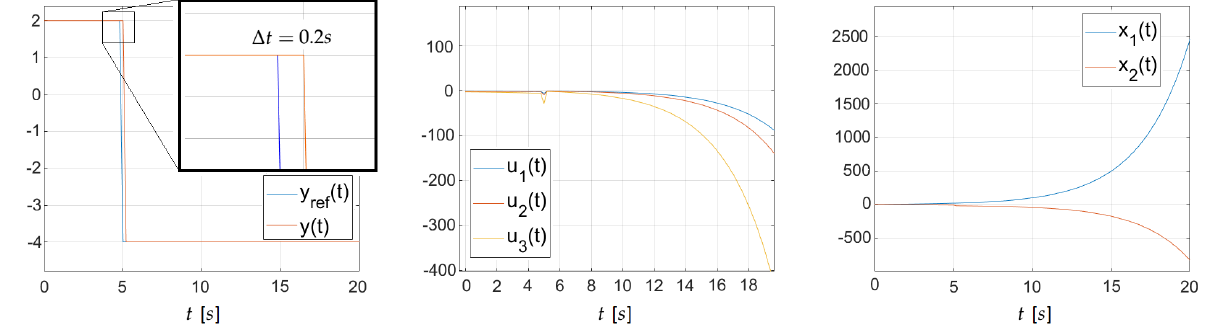
Figure 2. Perfect control plots: T -inverse, case ∆ t = 0.2 s.